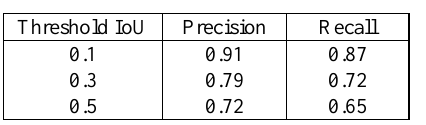
Table 1. The average Precision and Recall values on the test dataset.